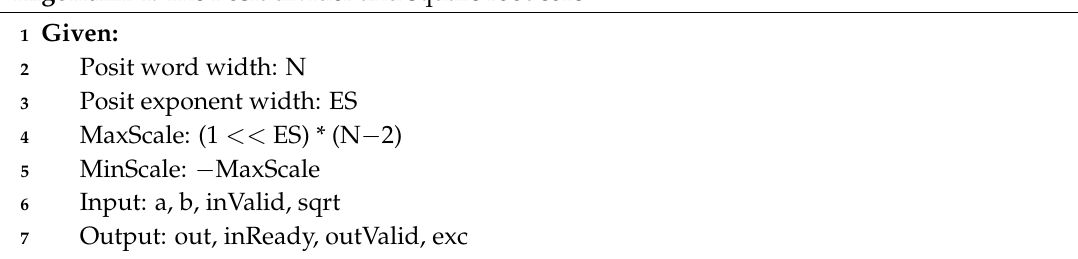
Algorithm 4: The Posit divider and square root